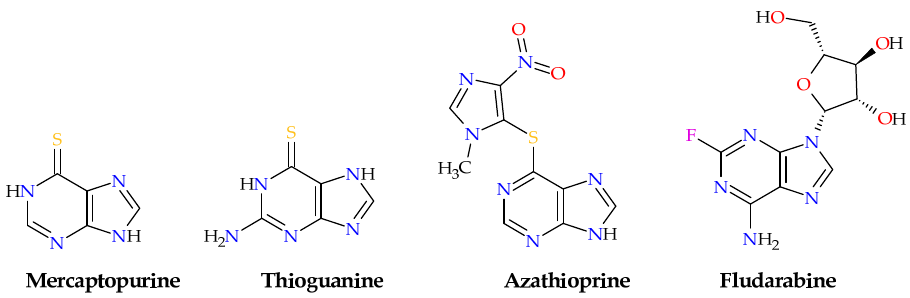
Figure 3. Purine antagonists used as drugs in cancer therapies.